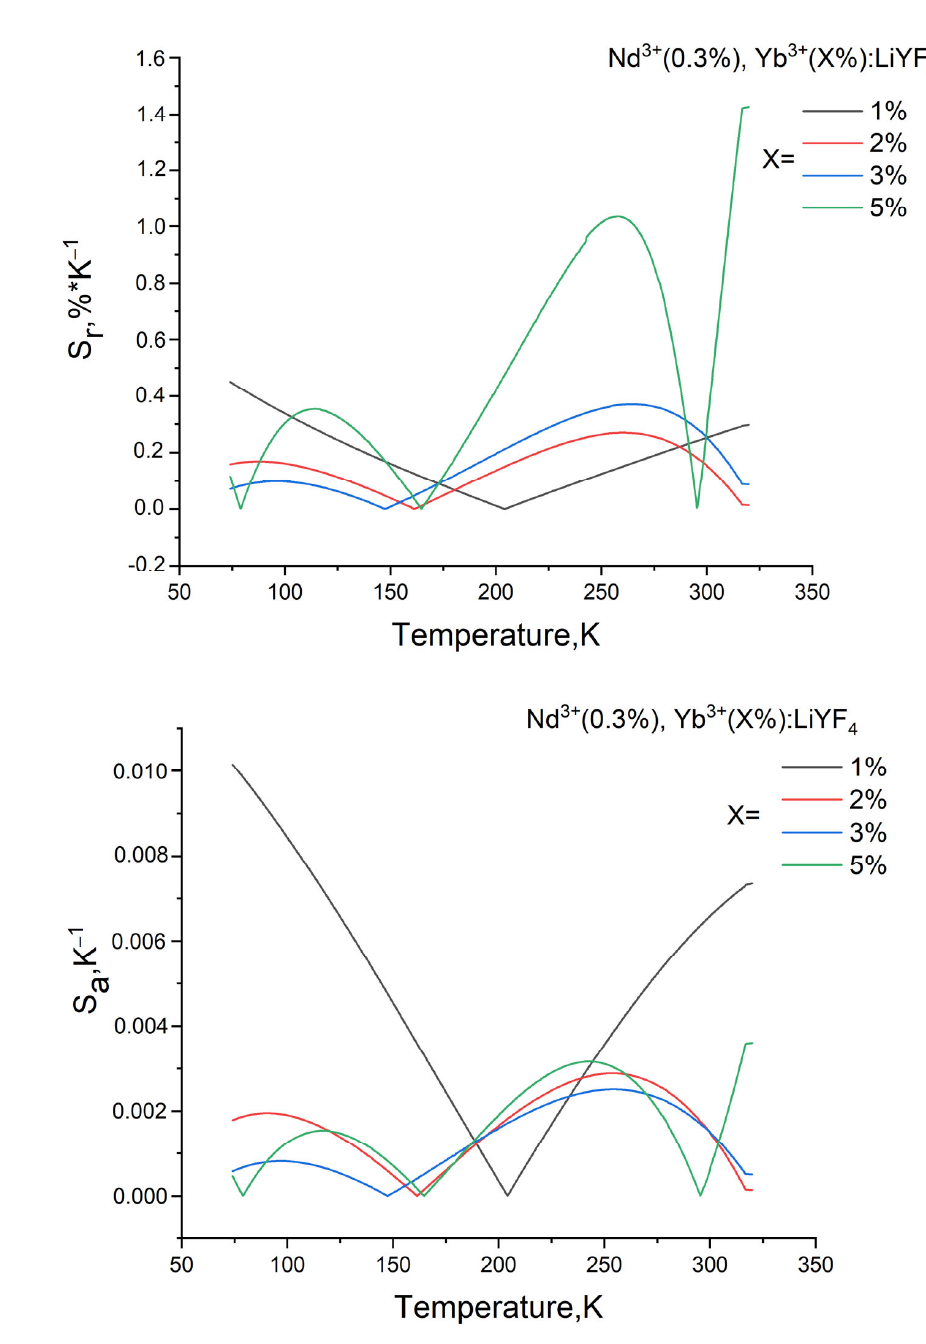
Figure 10. ( a ) Relative temperature sensitivity (S r ) and ( b ) absolute temperature sensitivity (S a ) as a function of temperature for Nd 3+ , Yb 3+ :LiYF 4 samples.